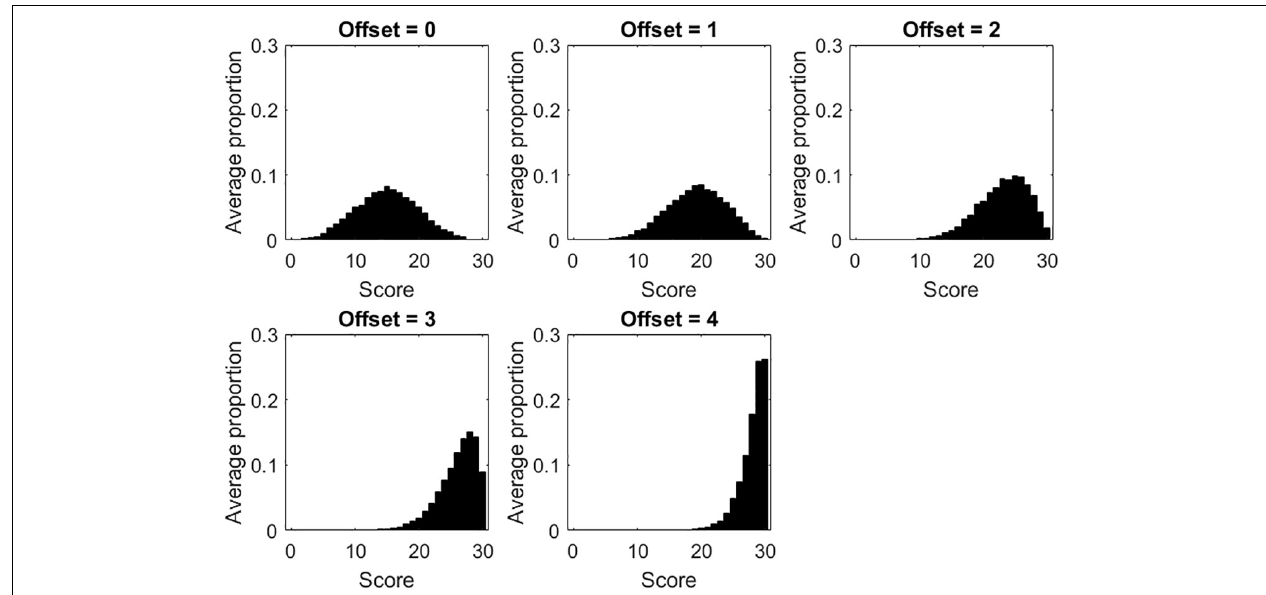
FIGURE 1 | Score distributions for each of the five offset conditions in the tests with dichotomous items.